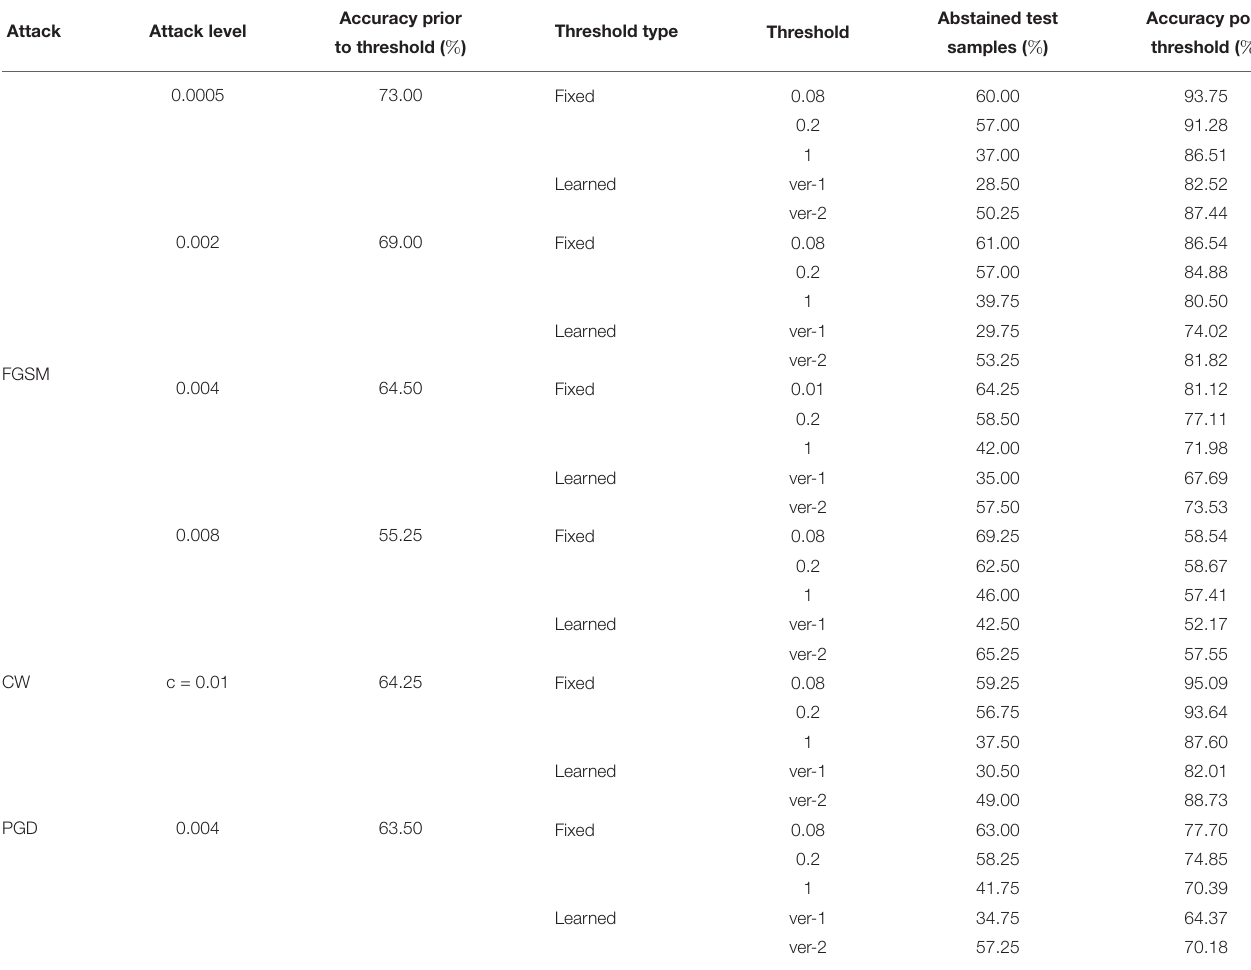
TABLE 9 | Detection of failure in BDNNs—DermaMNIST dataset tested under various types of adversarial attacks.